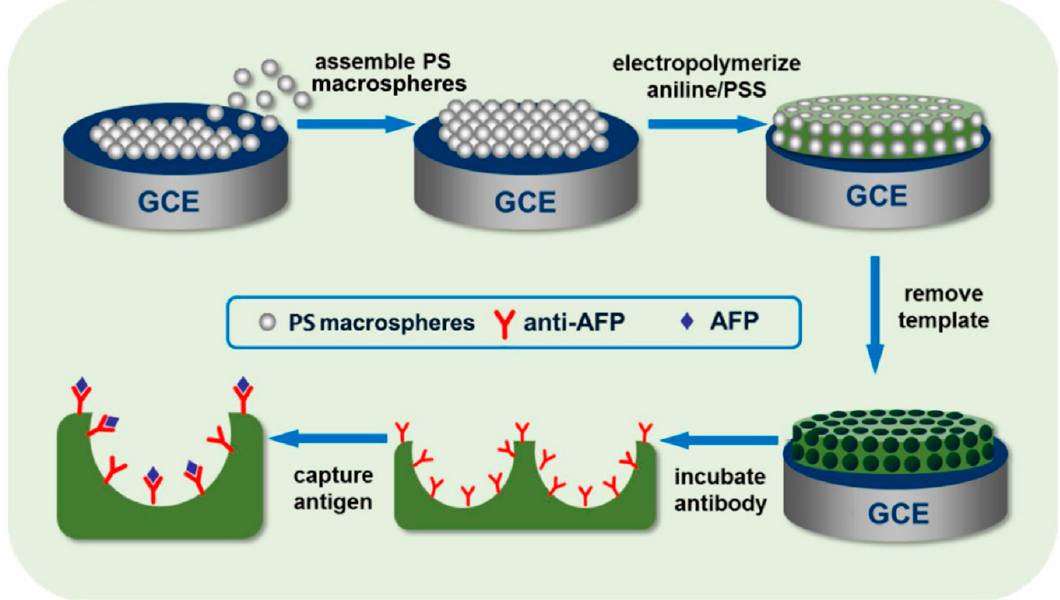
Figure 11. Sketch of fabrication of an immunosensor by using beads template. Image reproduced from [106] with permission.